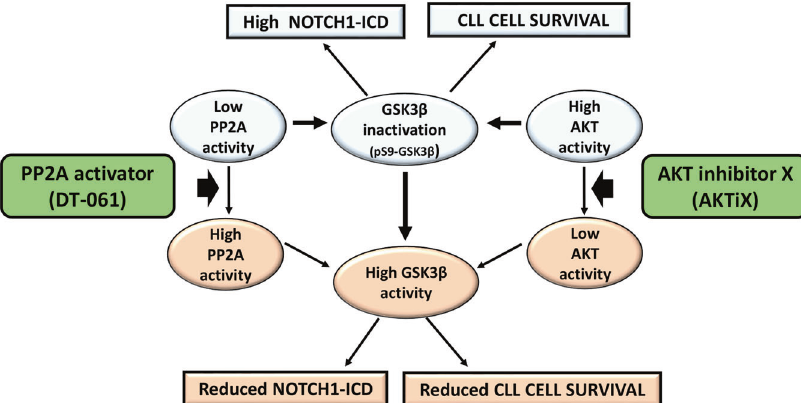
Fig. 8 Schematic representation of the signaling network sustaining NOTCH1-ICD levels and cell survival in CLL, as a potential therapeutic target. Constitutive NOTCH1-ICD levels and CLL cell survival are sustained by GSK3 β inactivation, due to an impaired PP2A activity and a high AKT activation, which both induce S9-GSK3 β phosphorylation (pS9-GSK3 β ). The increase in PP2A activity induced by the highly speci fi c activator DT-061 or the inhibition of AKT with the AKTiX inhibitor enhance GSK3 β activity, leading to a decrease in NOTCH1-ICD levels with a concomitant reduction in CLL cell